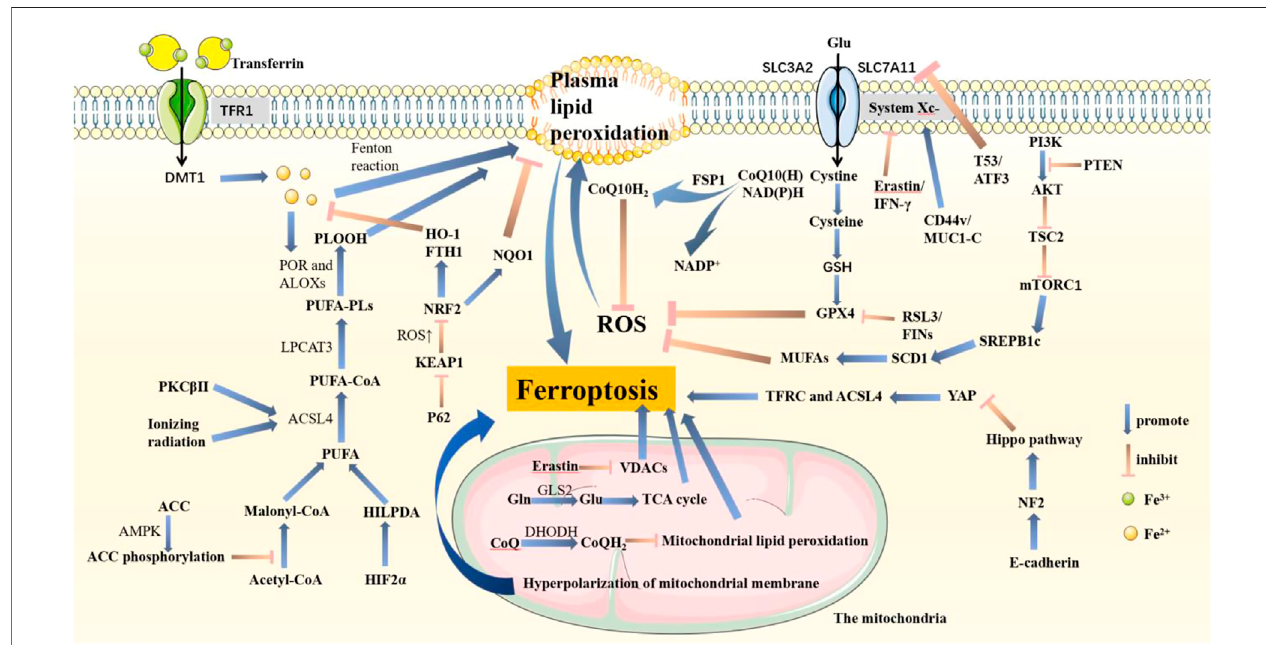
FIGURE 1 | Pathways associated with ferroptosis in cells. PTEN promotes lipid peroxidation and ferroptosis by inhibiting the PI3K-AKT-mTOR pathway. System Xc − , composed of SLC3A2 and SLC7A11, is an important structure that helps synthesize GSH. GSH promotes GPX4 to inhibit ferroptosis. In this pathway, T53 and ATF3 acting on SLC7A11, RSL3 and FINs acting on GPX4, and Erastin and IFN- γ acting on System Xc-are important inhibitors that are conducive to ferroptosis. Also, CD44v and MUC1-C acting on System Xc-promote GPX4 synthesis. P62-KEAP1-NRF2 goes against ferroptosis by increasing NQO1, HO-1, and FTH1. Fe3 + bindstotransferrinand enterscellsthroughTFR1,whichisreducedtoFe2 + andreleased fromDMT1-mediatedendosomes.Plasmalipidperoxidation isinducedbythe Fentonreactionprocess.PUFAisactivatedbyACSL4andLPCAT3andcatalyzedbyPORandALOXstopromoteROSaccumulation.TheHIF2 α -HILPDAaxis,PKC β II, and ionizing radiation both positively regulate ferroptosis, in which PKC β II and ionizing radiation acted on ACSL4. AMPK fi ghts ferroptosis by promoting ACC phosphorylation. E-cadherin activates the NF2-Hippo pathway and then inhibits YAP expression. Therefore, TFRC and ACSL4 are also inhibited, resulting in tumor cells growing and metastasizing more quickly. FSP1 inhibits ferroptosis by reducing CoQ10. In mitochondria, Erastin induces lipid peroxidation in both VDACs and mitochondrial potential hyperpolarization. GLS2 helps Gln transform into Glu, which enters the TCA cycle to promote ROS production. Besides, DHODH inhibits